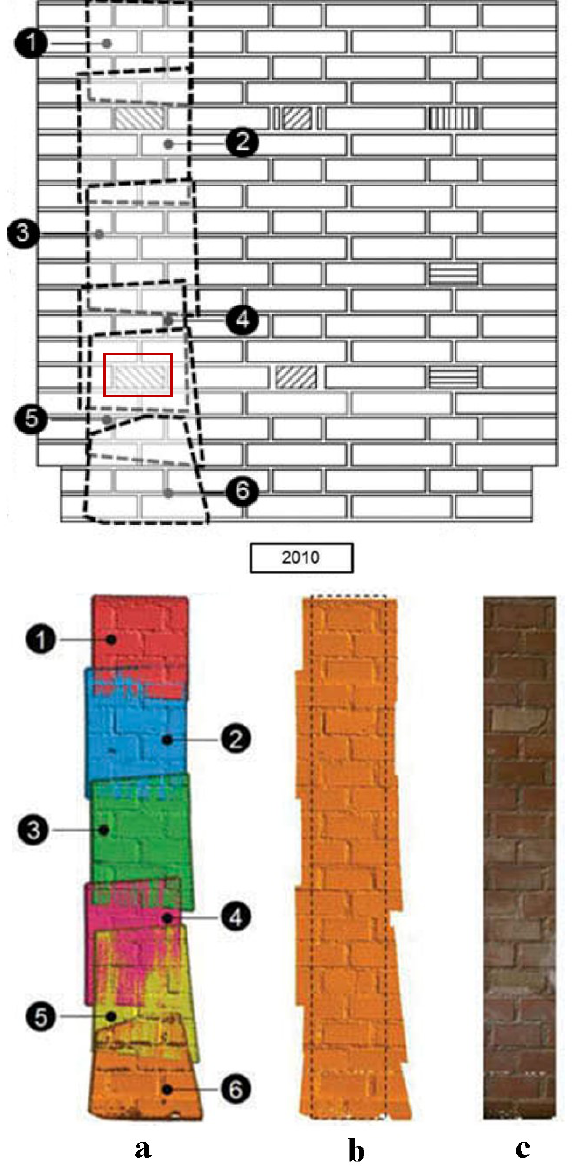
Figure 8. On the top: footprints of the scans necessary to survey the front wall area in 2010 (in red the detail shown in Figure 8); on the bottom (a) the aligned scans, (b) the merged mesh and (c) the photo-textured 3D model (Bitelli et al., 2015).